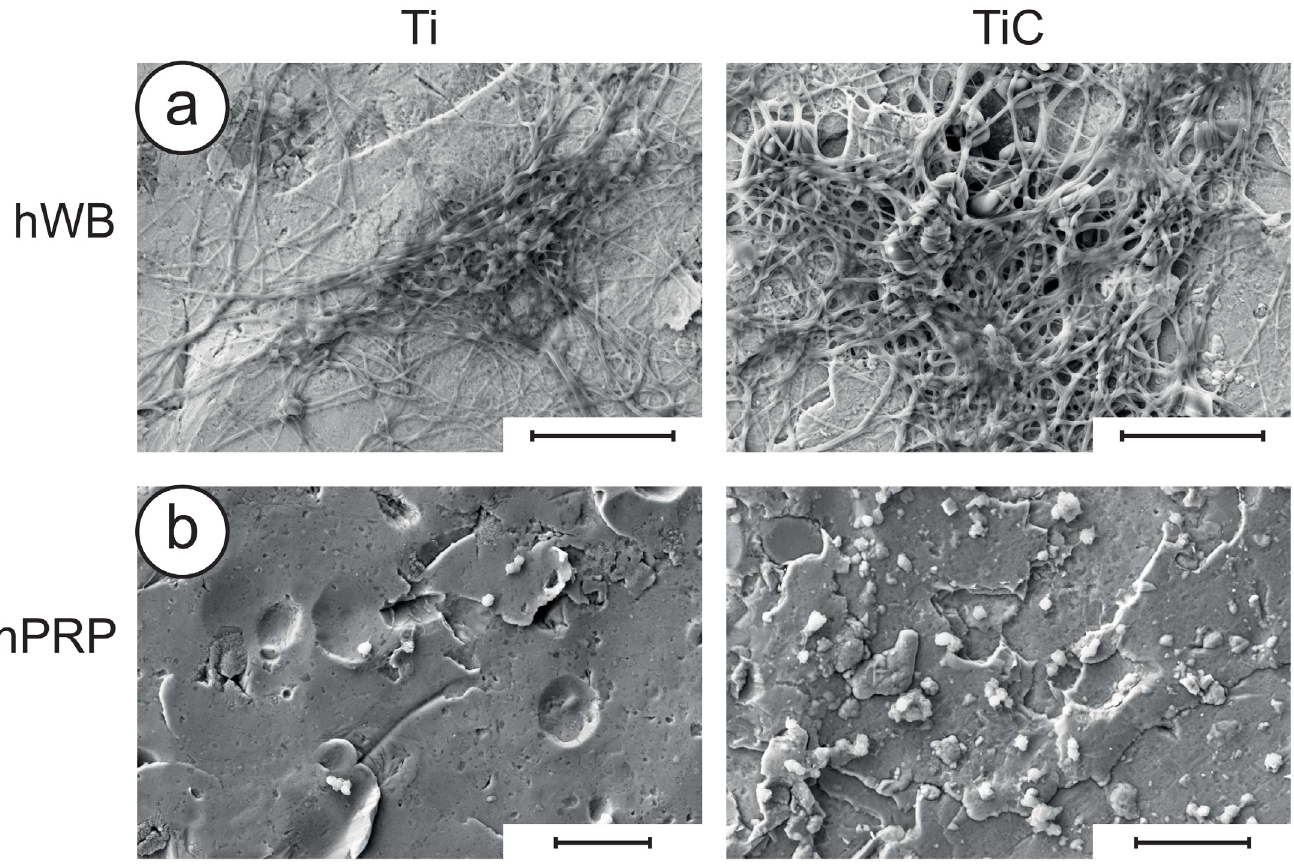
Fig 8. SEM analyses of micrographs of hWB and hPRP on differently treated substrates. Panel a: uncoated (left) and TiC coated titanium disks (right) treated with human Whole Blood (hWB) for 4 minutes. Panel b: uncoated (left) and TiC coated titanium disks (right) treated with human Platelet-Rich Plasma (hPRP) for 90 minutes. In both cases, the TiC coated titanium disks present a more efficient formation of blood clots and a higher number of adhering platelets, compared to the uncoated cases. In each figure, the bars represent 10 μ